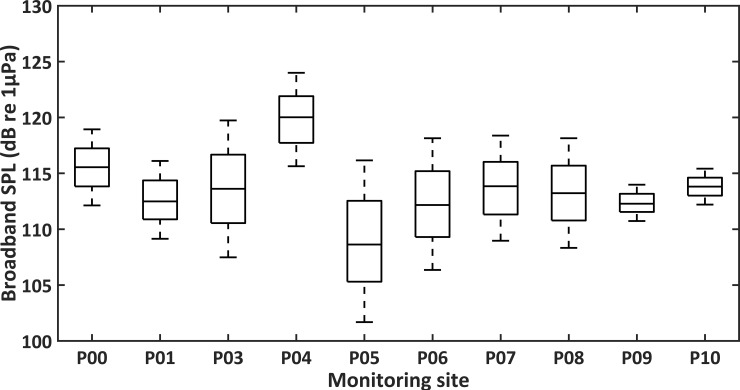
Spatial variation of broadband sound pressure levels (broadband SPLs) at the PAM sites.The differences of broadband SPLs from 20 Hz to 144 kHz among ten monitoring sites (Median; Whisker: 25th–75th).